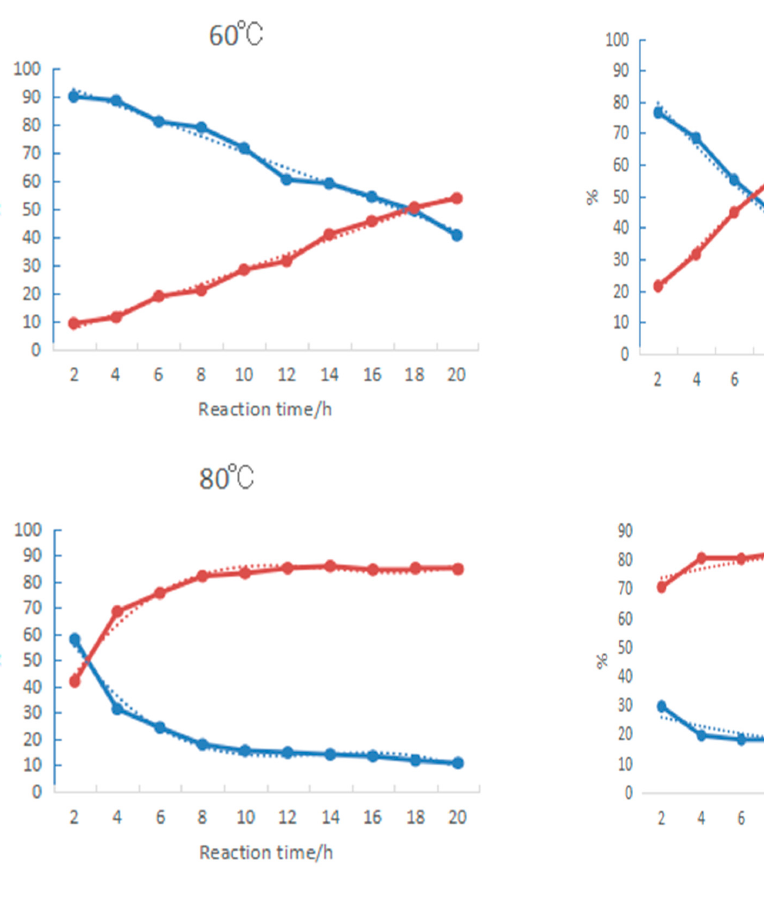
Figure 4. Effect of temperature changes on the camphene esterification reaction. Reaction conditions: m(camphene):m(acetic acid):m(tartaric acid):m(boric acid) = 10:25:0.5:0.4, reaction temperature of 70 ◦ C, and reaction time of 18 h.